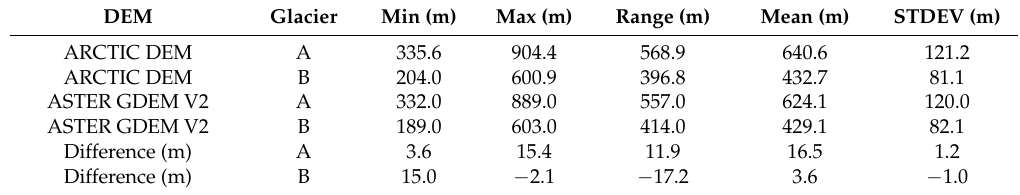
Table 4. DEM characteristics for the Arctic DEM and the ASTER GDEM V2 for two randomly selected glaciers. Min is minimum, max is maximum elevation, STDEV is standard deviation. DEM Glacier Min (m) Max (m) Range (m) Mean